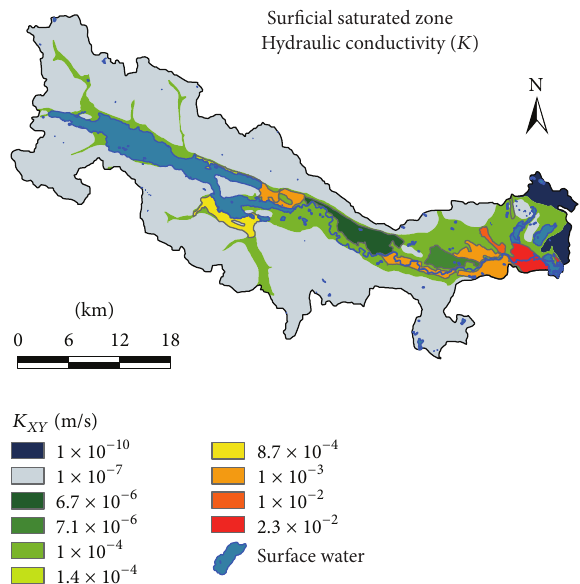
Figure 8: Spatial representation of the initial hydraulic conductivity